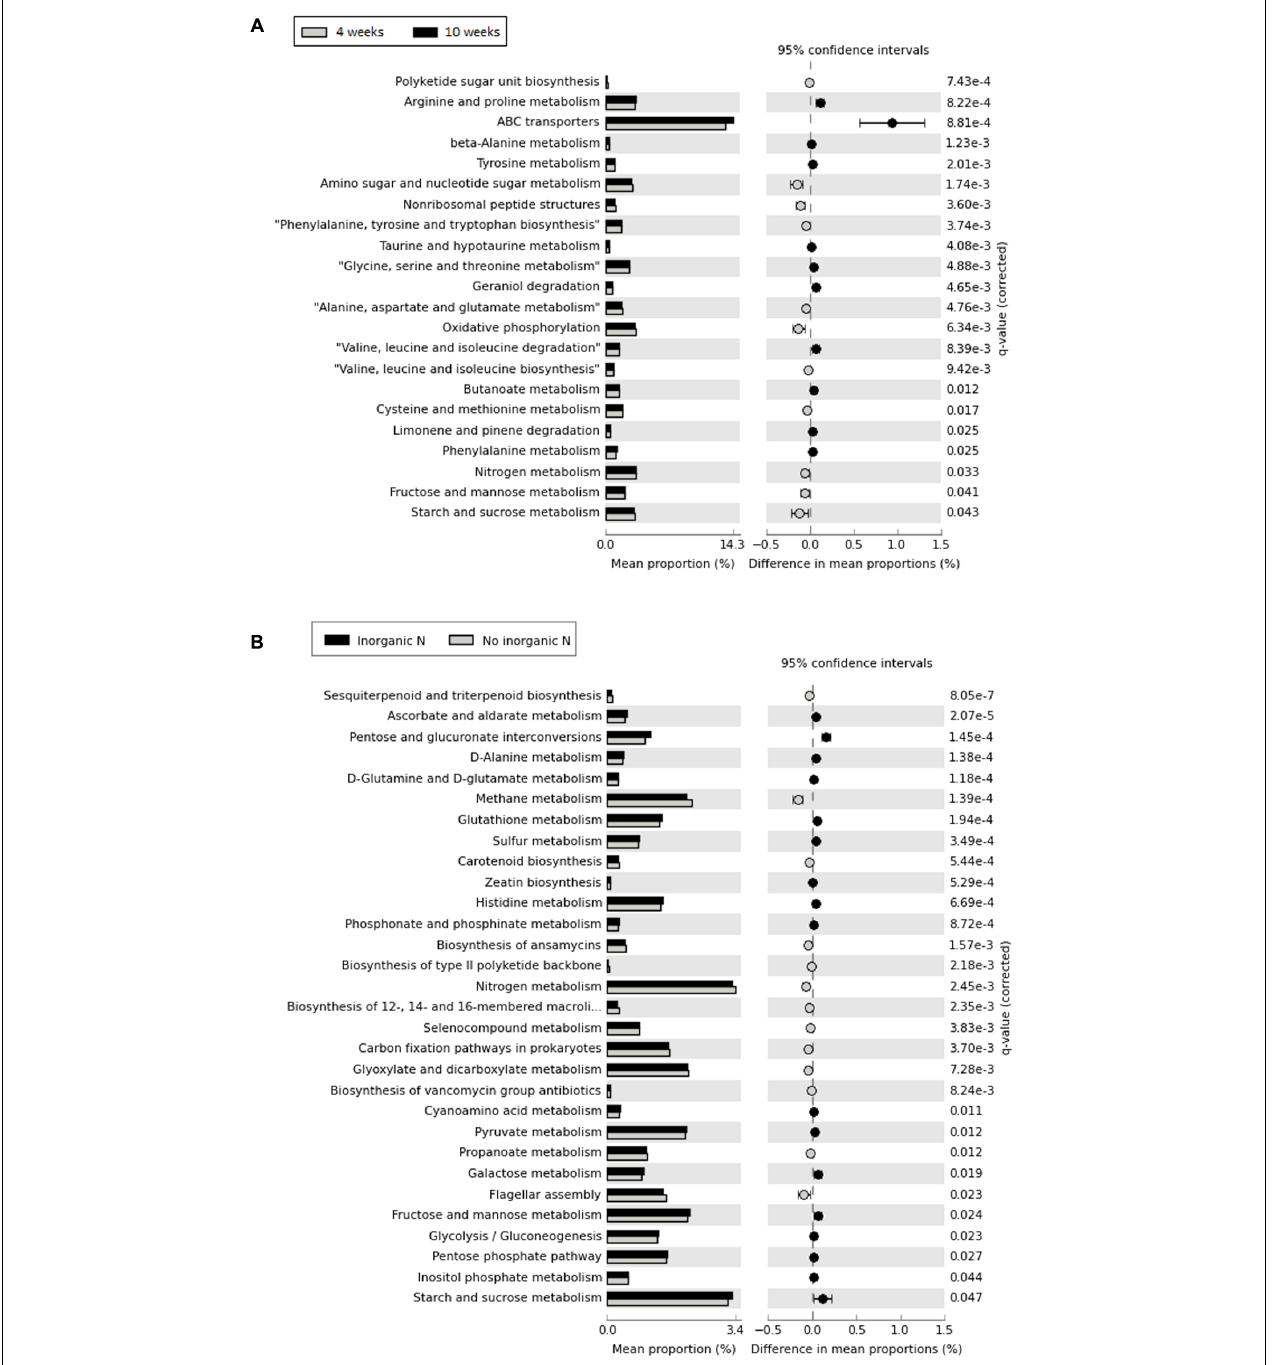
FIGURE 7 | Extended error bars showing statistical differences of 16S rRNA gene-predicted functional profiles obtained with Tax4Fun. (A) – comparison between two developmental stage (rhizosphere collected after 4 weeks and rhizosphere collected after 10 weeks); (B) – comparison between addition of inorganic N, with “no inorganic N” group represented by rhizosphere samples from organic N and zero N treatments and “inorganic N,” representing rhizosphere samples from both medium and high inorganic N treatments. Corrected p -values were calculated using Benjamini–Hochberg FDR correction ( p < 0.05).